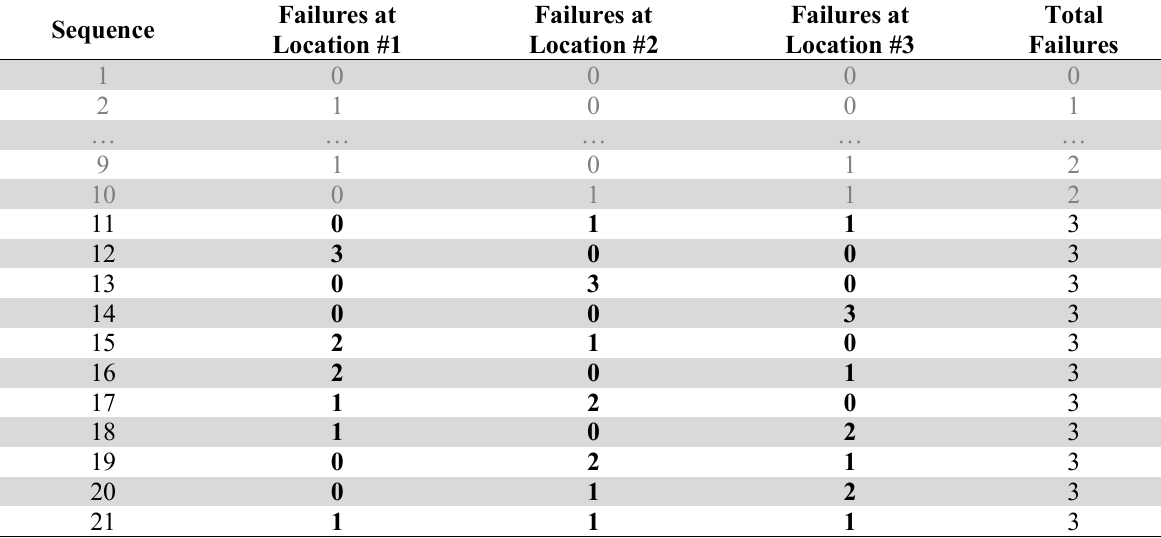
Table 2 The combinatorial table for M i = 3 and N i =